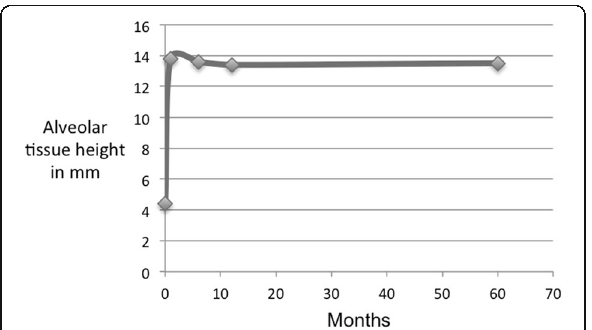
Fig. 3 Alveolar tissue height (in true mm) over a 5-year period in the 12-month